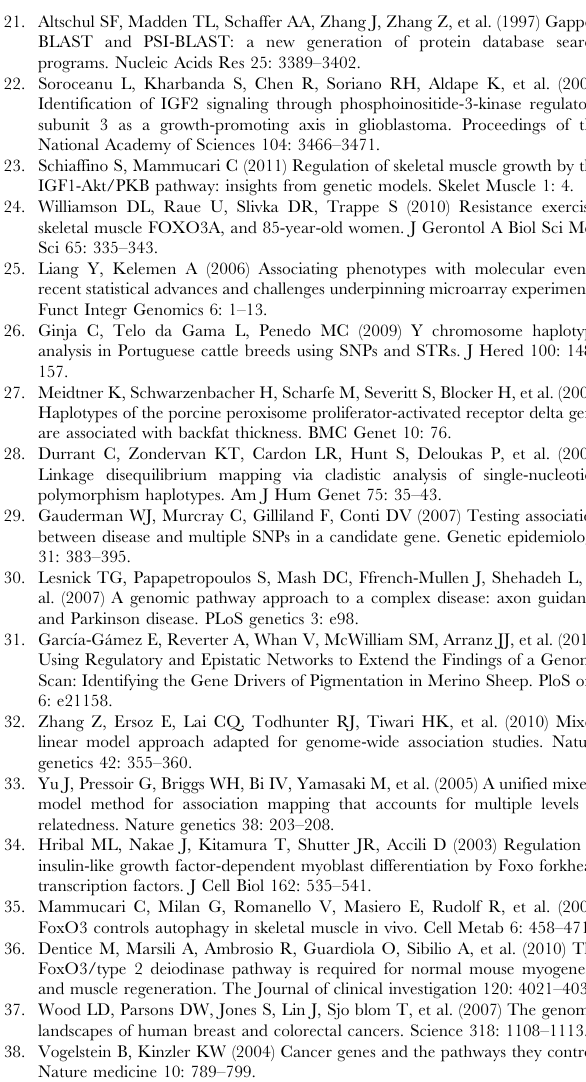
Table S1 The 57 SNPs with their positions in the insulin and insulin growth factor-1/FoxO (IGF1-FoxO). Table S2 The main effects and the effects of interaction (epistatic effects) of the makers from the IGF1/FoxO signal transduction pathway in the simulation experiment. Table S3 The primer sequences for analysis of 23 identified SNPs. Table S4 The comparment of statistical power between our CGSA and candidate gene approach.